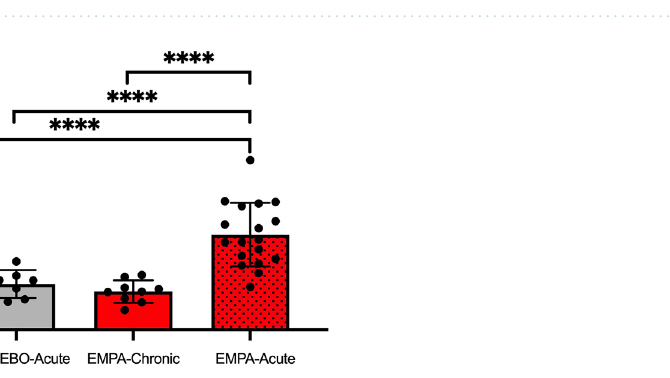
Figure 5. Myocardial interstitial concentrations of metabolites. The myocardial interstitial concentration of TCA cycle intermediates (citrate, succinate and malate) and purine metabolites (adenosine, hypoxanthine, inosine and xanthine) during stabilization, ischemia and reperfusion. Data are mean ± SEM. Statistical significance is shown as * p < 0.05 EMPA-Acute vs. EMPA-Chronic, † p < 0.05 EMPA-Chronic vs. PLACEBO- Chronic.